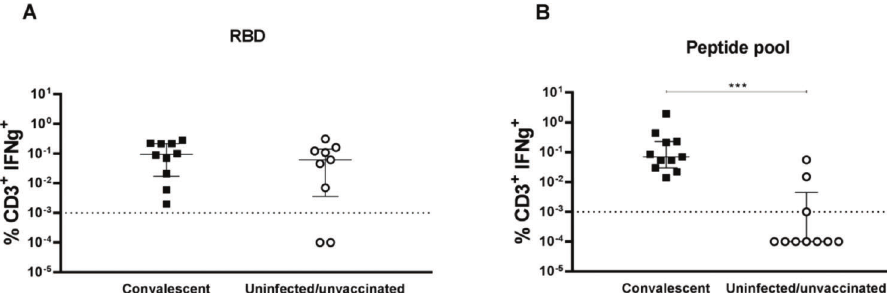
Figure 3 - Comparison of IFN- g production by T cells stimulated with a SARS-CoV-2 recombinant protein or peptide pool. PBMCs from COVID-19 convalescent individuals (black squares) (n=11) and from uninfected/unvaccinated donors (white circles) (n=10) were stimulated for five days with 500 ng/mL RBD protein (A) or were incubated for 18h with a mixture of grouped SARS-CoV-2 peptide pools (M + N + S) at a final concentration of 1 m g/mL (B). The logarithmic scale represents the percentage of T cells producing IFN- g . Scatterplots show lines at the median with interquartile ranges. The dashed line represents the assay cut-off value of 0.001%. IFN- g expression by CD3 + T cells was analyzed by intracellular flow cytometry. T-tests and nonparametric Mann-Whitney tests were used to calculate p values. Statistically significant differences were observed between the groups when cells were stimulated with SARS-CoV-2 peptide pools (*** p o 0.001).